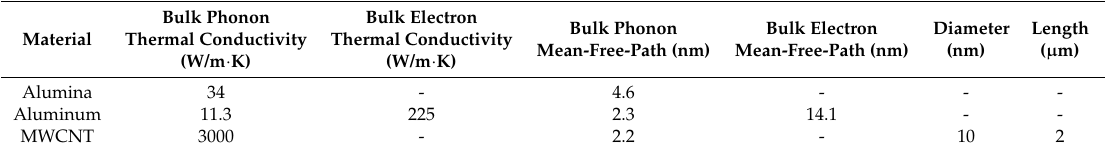
Table 2. Properties for alumina, aluminum, and MWCNTs.